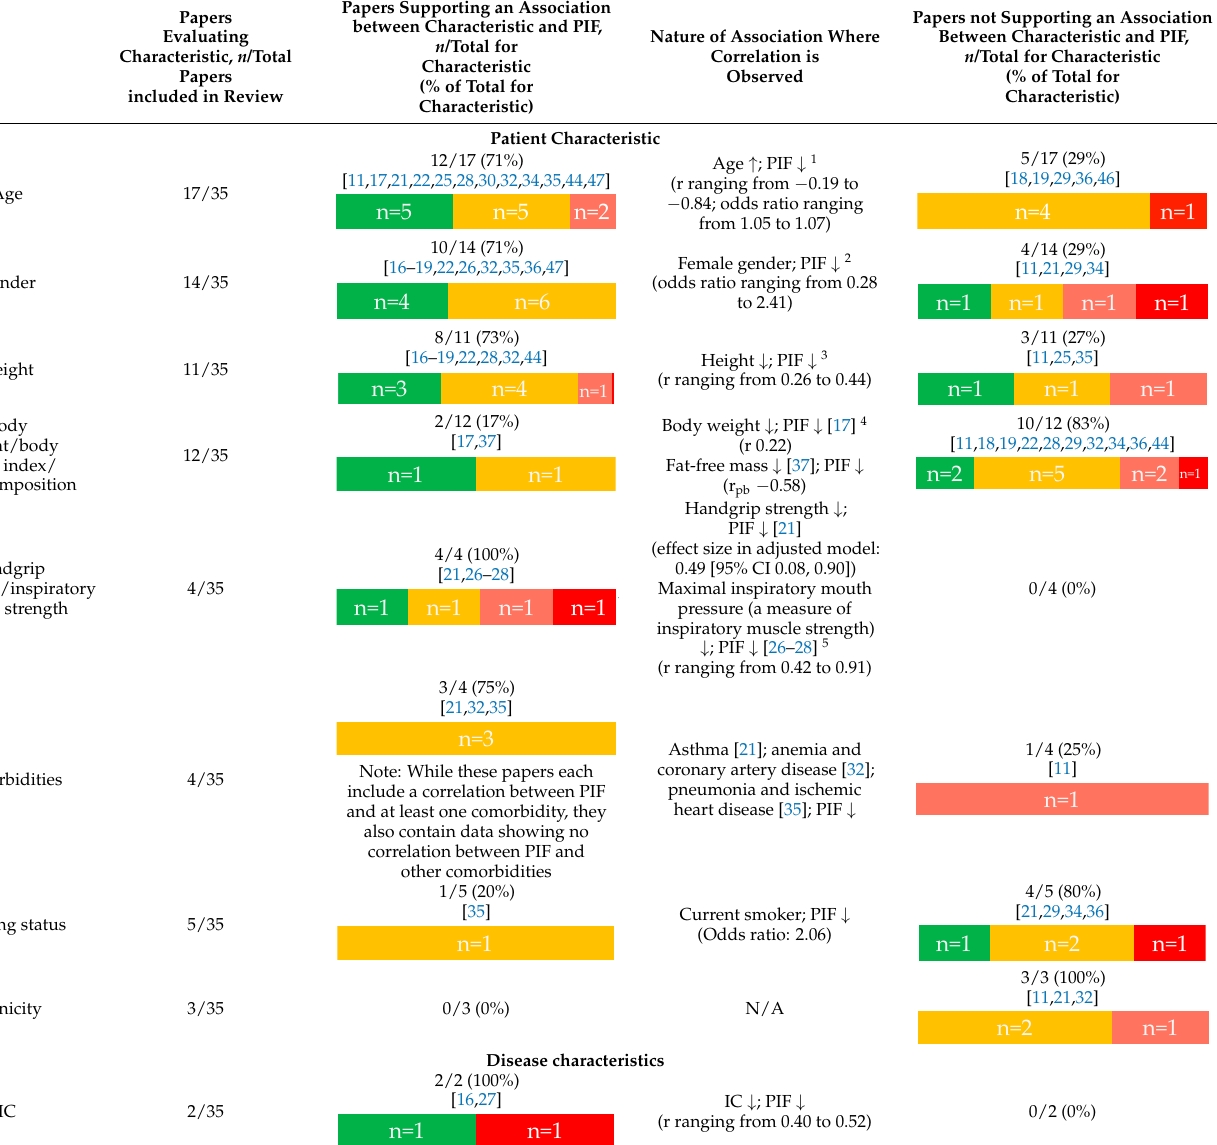
Table 1. Patient and disease characteristics associated with PIF.